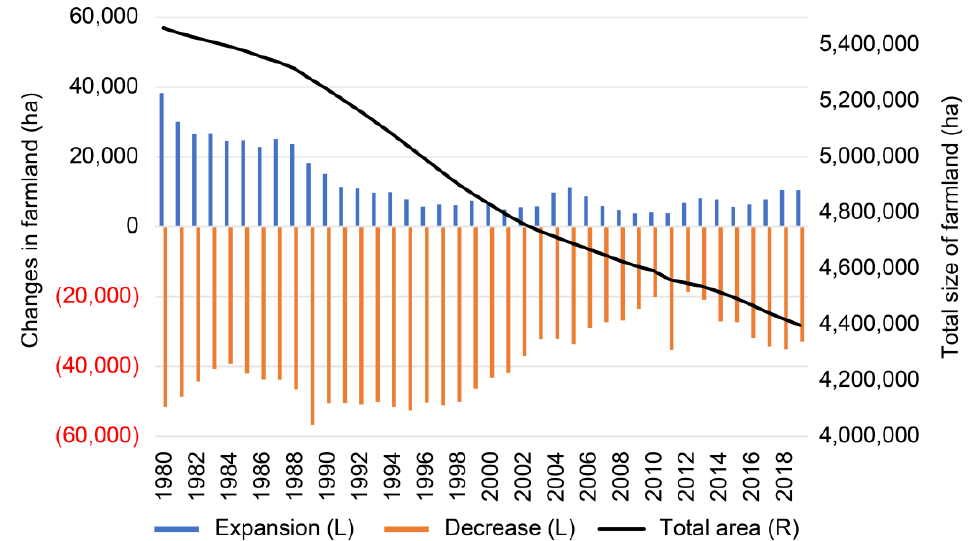
Figure 1. Changes in farmland area in Japan (ha) from 1980 to 2018. The number in parenthesis means the decreasing number of farmland (ha per year). Source: Ministry of Agriculture, Forestry and Fisheries [1].